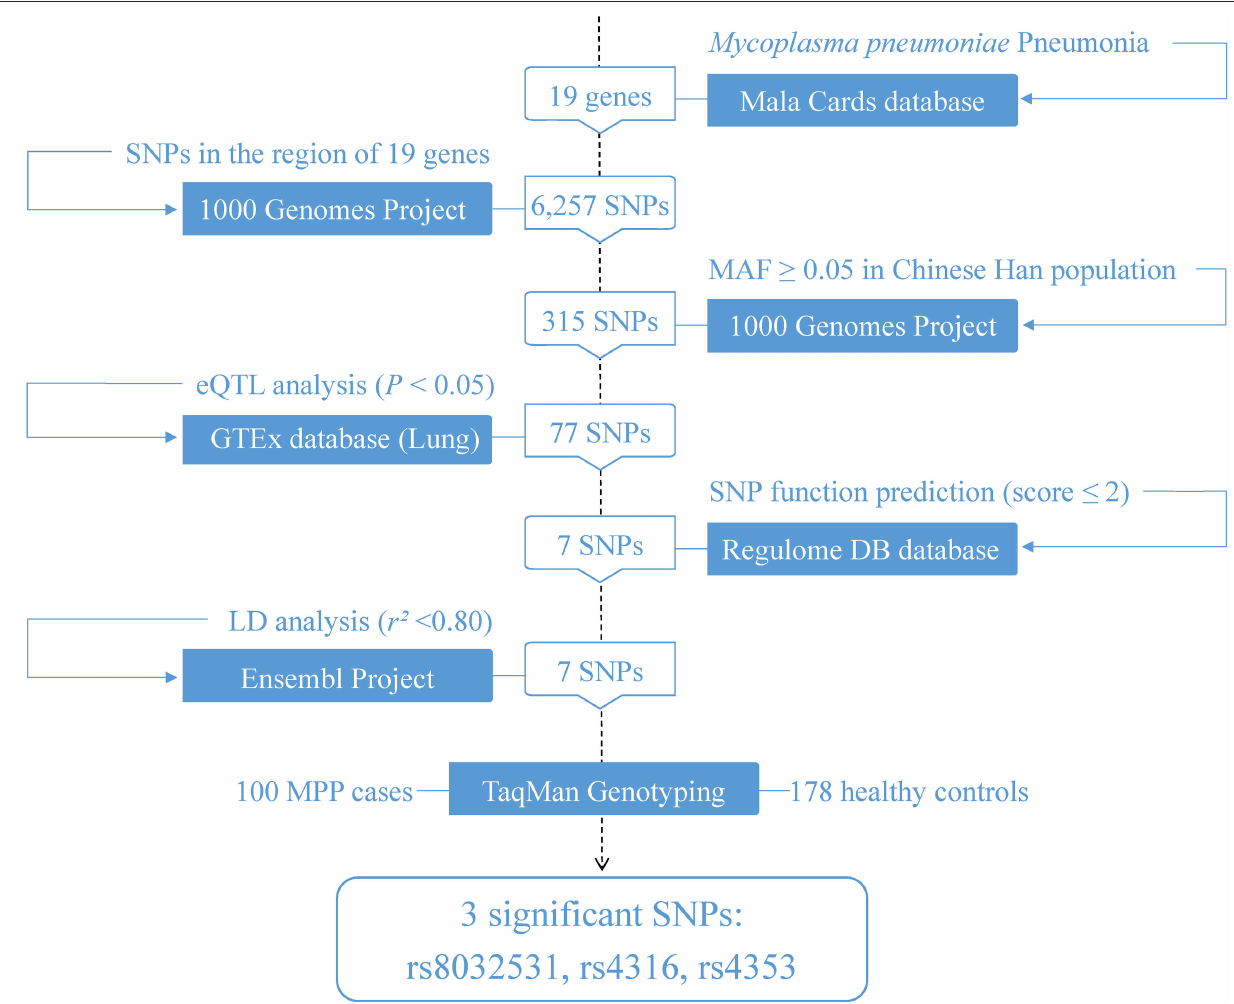
FIGURE 1 | Flowchart of the study design. eQTL, expression quantitative trait locus; SNP, single-nucleotide polymorphism; LD, linkage disequilibrium; MAF, minor allele